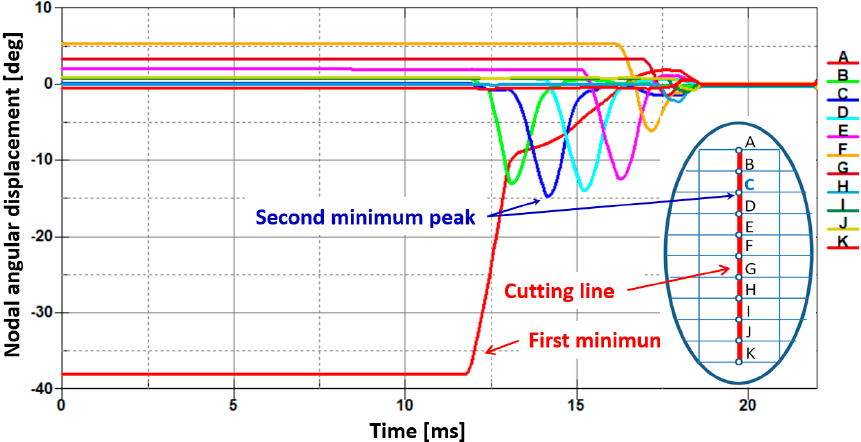
Figure 12. Juxtaposition of changes of an angular displacement in the function of time for each node situated on the cutting line and denoted by letters from A to K for the bottom sheet in a bundle with respect to the model presented in Figure 2.